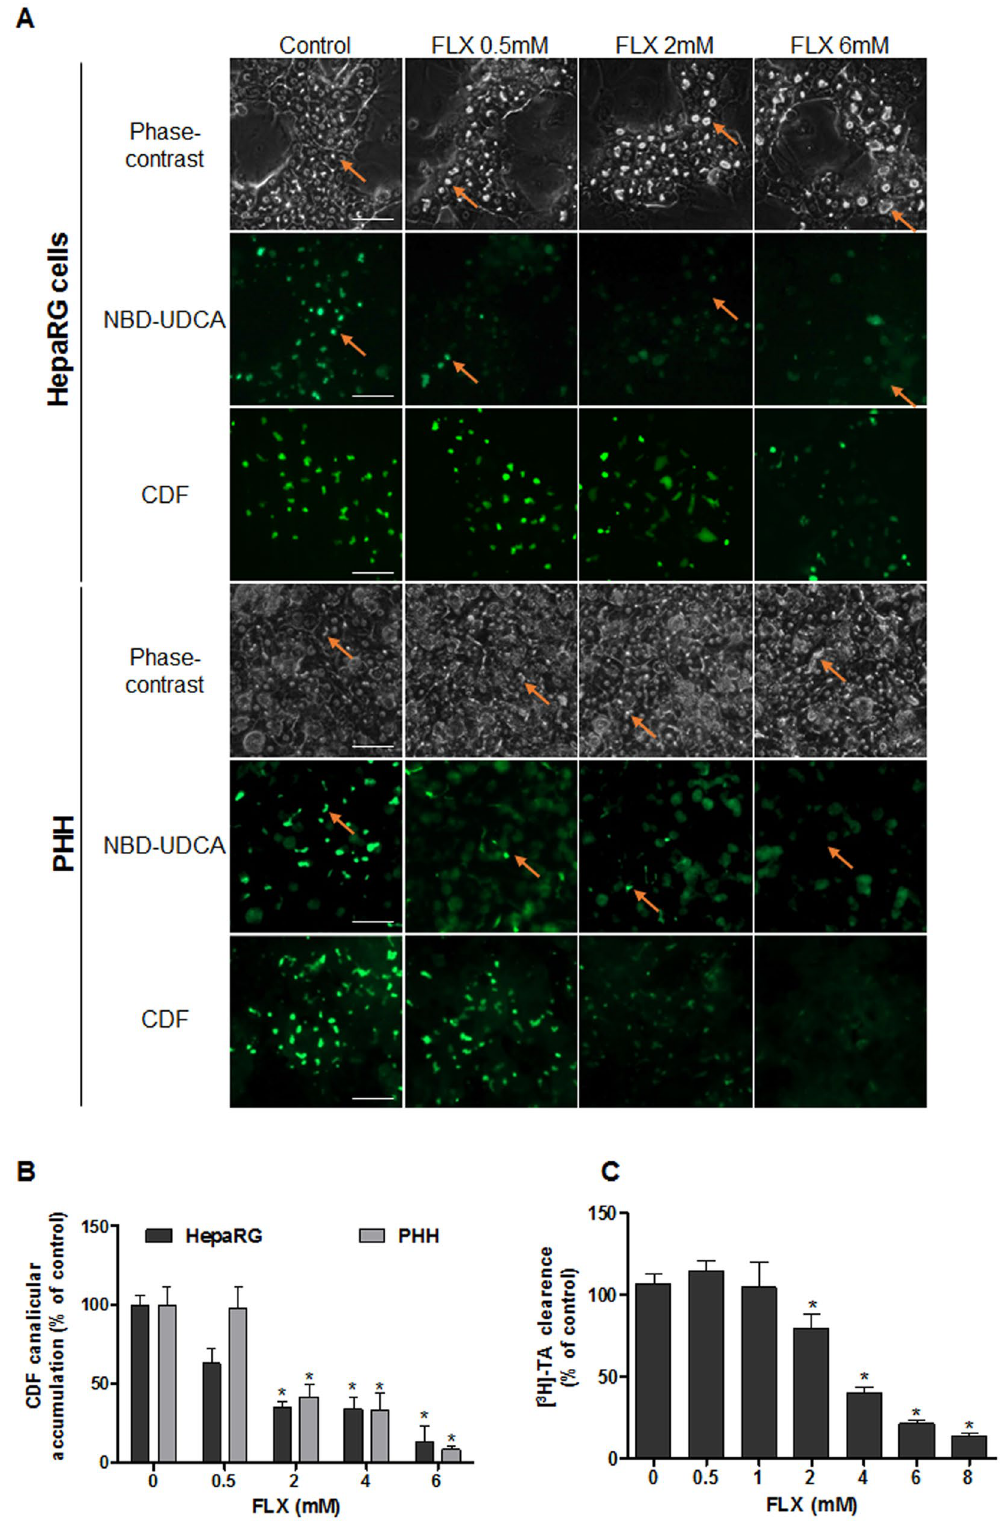
Figure 2. Effects of FLX on labelled bile acids and CDF clearance in HepaRG cells and PHH. ( A ) NBD- UDCA and CDF efflux in HepaRG hepatocytes and PHH treated for 2 h with different concentrations of FLX (0–6 mM). Orange arrows indicate fluorescence in BC (bar = 50 μ m). ( B ) Quantification of CDF accumulation in BC of HepaRG hepatocytes after FLX treatment using ImageJ 1.48 software as described in the Materials and Methods. ( C ) [ 3 H]-TA clearance in HepaRG cells treated with different concentrations of FLX (0–8 mM) for 2 h. Data were expressed relative to those of untreated cells arbitrarily set at 100%. They represent the means ± SEM of 3 independent experiments. * p < 0.05 compared with that of untreated